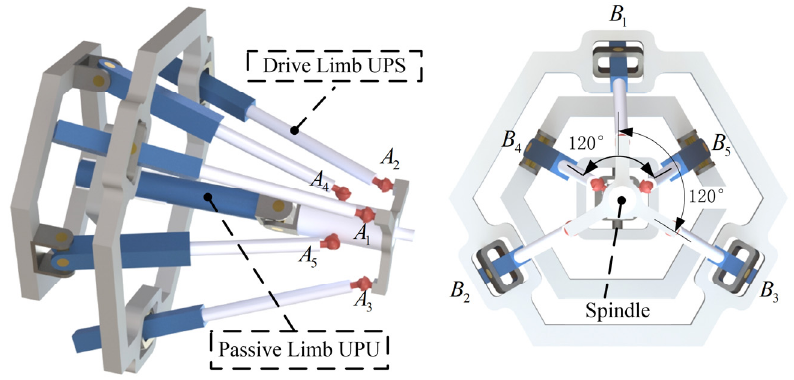
Figure 1. Integrated optimization design method.